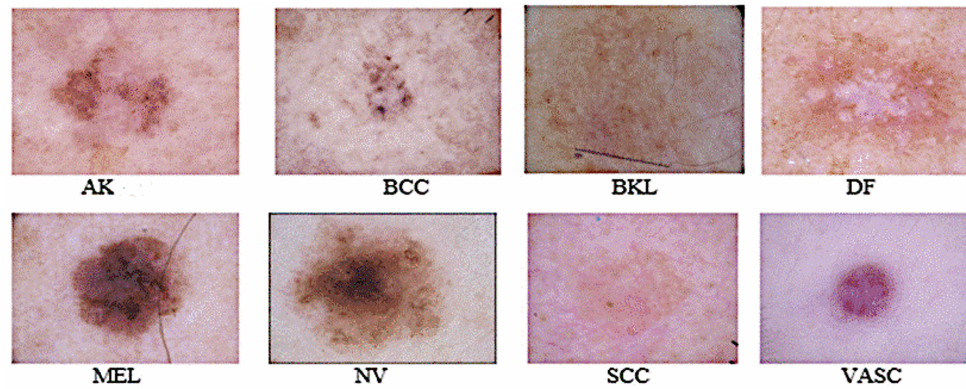
Figure 3. Sample images of eight skin diseases from the ISIC-2019